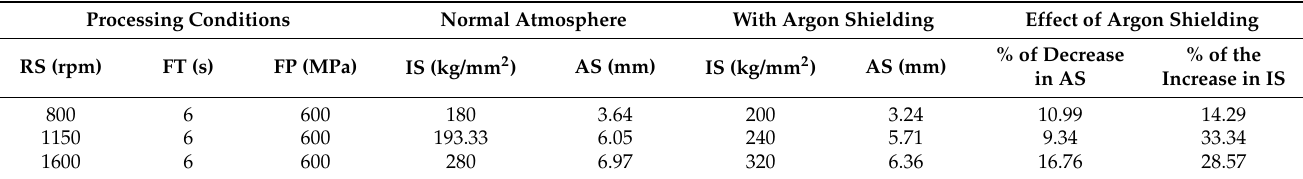
Table 14. Tabulation of experimental results.